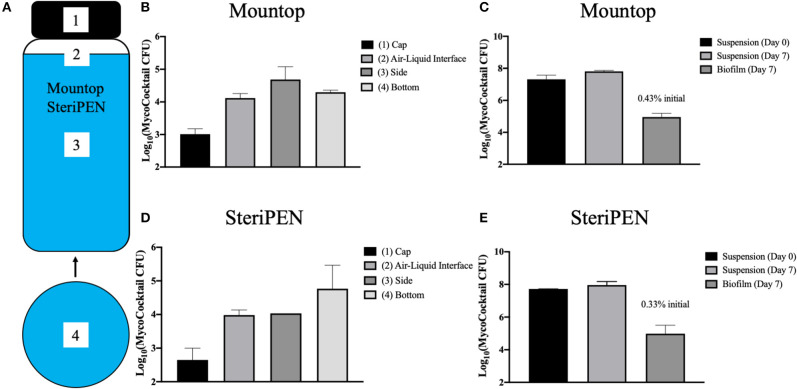
Biofilm formation within Mountop and SteriPEN water bottles contribute little to total CFU. (A) Four regions of each water bottle system were sampled with sterile synthetic swabs to quantify biofilm-associated CFU: the interior surface of the bottle cap (1), a 4-cm2 region at the air–liquid interface (2), a 4-cm2 region completely submerged in inoculum (3), and a 4-cm2 region of the interior bottom surface of the bottle (4). Mountop (B,C) and SteriPEN (D,E) systems were inoculated with MycoCocktail and an aliquot of the Day 0 suspension was plated for CFU. Bottles were then allowed to incubate undisturbed at room temperature for 7 days. At Day 7, an aliquot of the suspension was plated for CFU and biofilms within each system were sampled. Biofilm swabs were then plated for CFU and the CFU/cm2 in each area was applied to each bottle's total surface area. Biofilm CFU was calculated as a percentage of the initial Day 0 suspension. (B,D) CFU of each region sampled for biofilm-associated CFU. (C,E) CFU of suspensions at Day 0 and Day 7 are compared to that of the biofilm at day 7. n = 2 independent experiments.